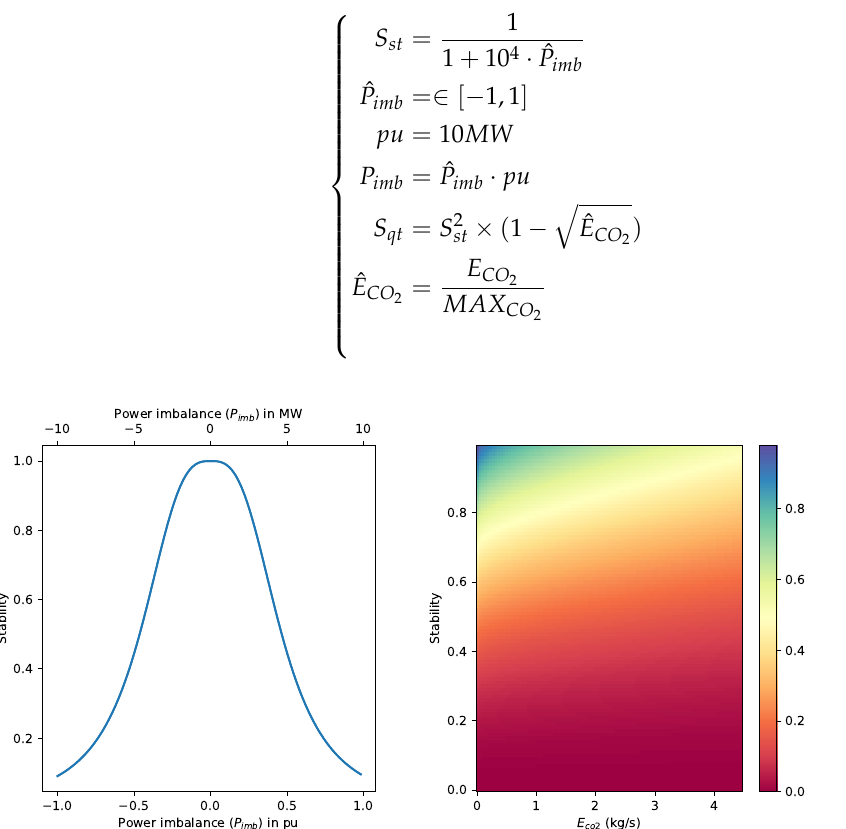
Figure 11. Plots of stability and quality from Equation